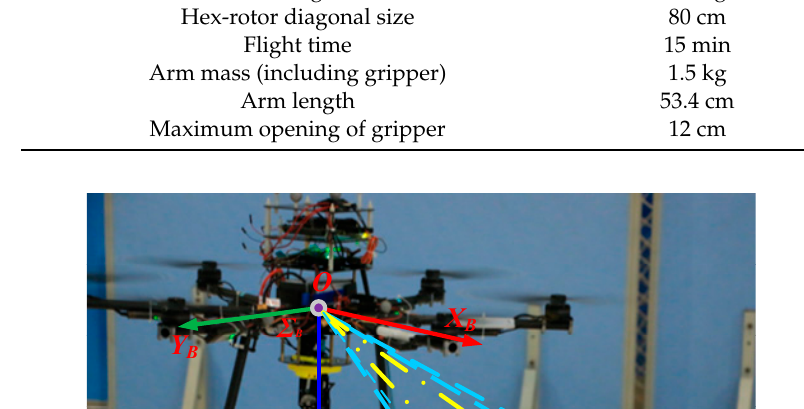
Table 1. Parameters of aerial manipulator.